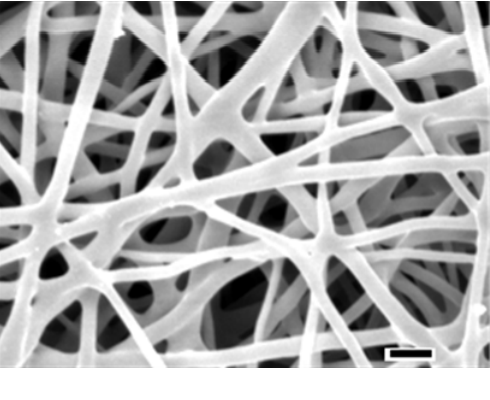
Figure 5. (a) SEM image of PLLA nanofiber, (b) SEM image of stereocomplexed PLA nanofiber, and (c) WAXD profiles of PLA nanofibers